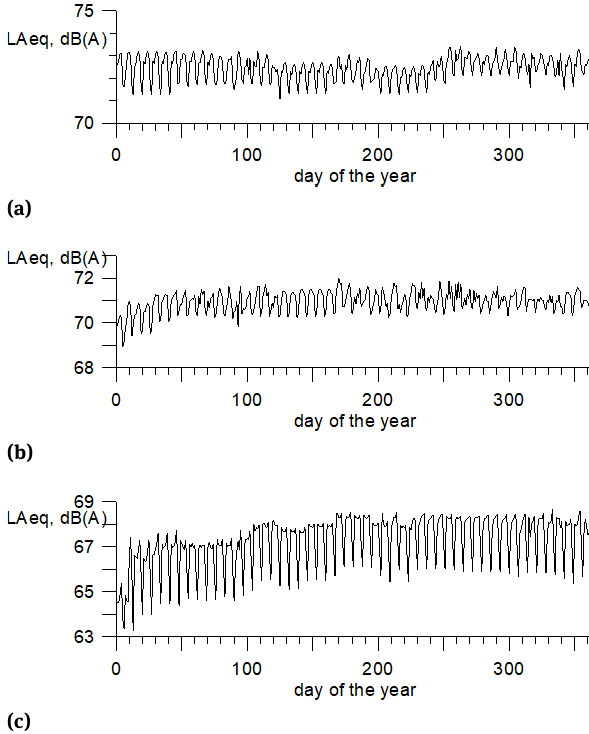
Table 4: Selected parameters of the model at location no. 2